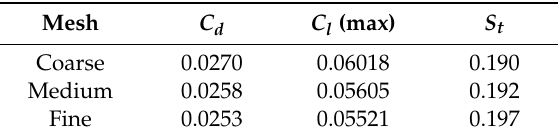
Table 1. Mesh convergence analysis